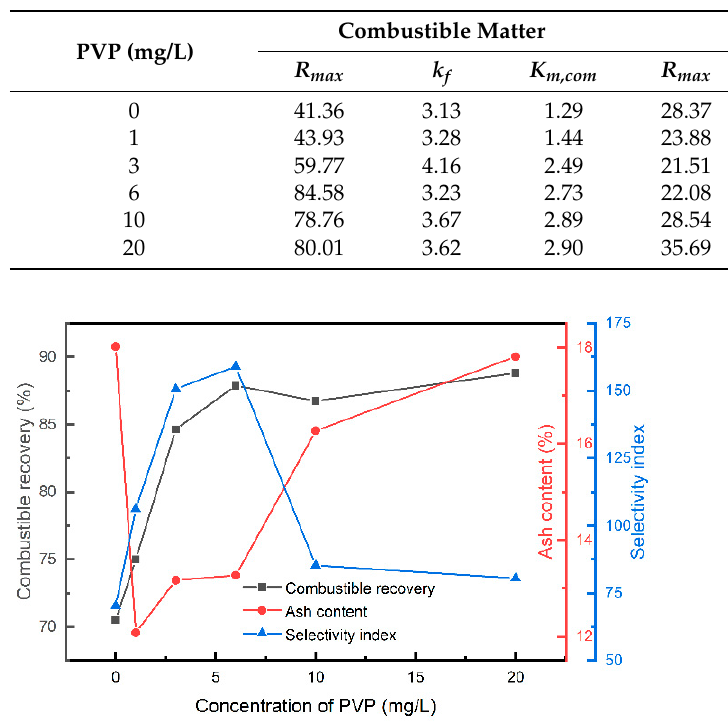
Figure 5. Combustible recovery (gray), ash content (red), and selectivity index (blue) of coal slime flotation with various concentrations of PVP.